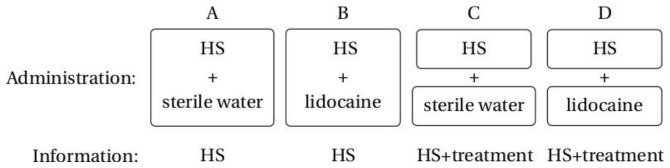
Experimental setup.